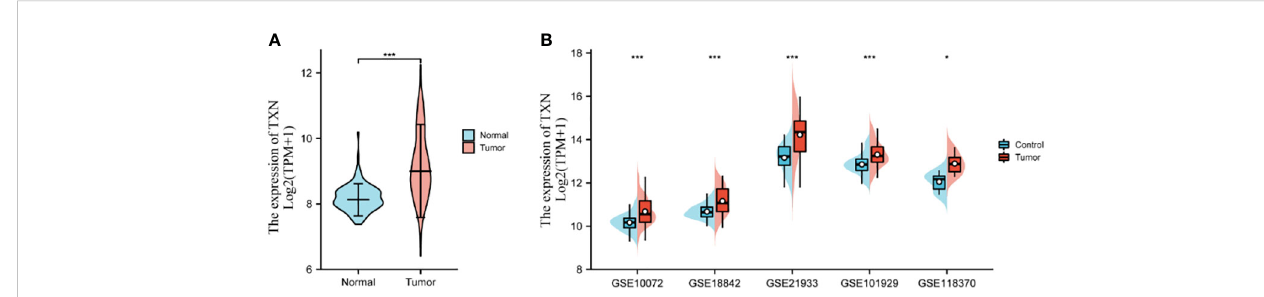
FIGURE 7 Levels of expression analysis of TXN in (A) the TCGA dataset and (B) the fi ve GSE datasets. *p < 0.05, ***p <